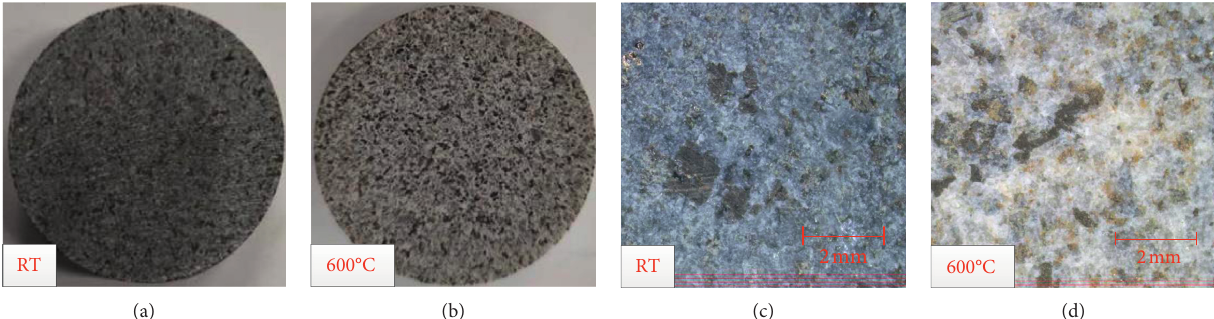
Figure 4: The surface color of granite (a, c) RT; (b, d) 600 ° C; (c, d) USB Industrial Microscope (Shenzhen Jingtuo Youcheng Technology Co. Ltd, JT-H6)).